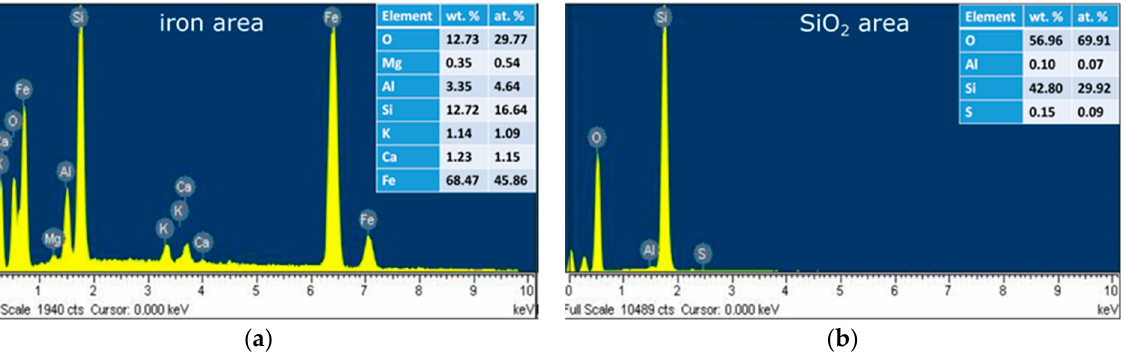
Figure 6. EDX spectrum and elemental quantification for the iron particle ( a ) and surrounding area ( b ). Multiple chemical variation, recorded by EDX analysis, leads to the conclusion of crystallographic phase variation for different particle sizes. The recorded XRD patterns are presented in Figure 7.